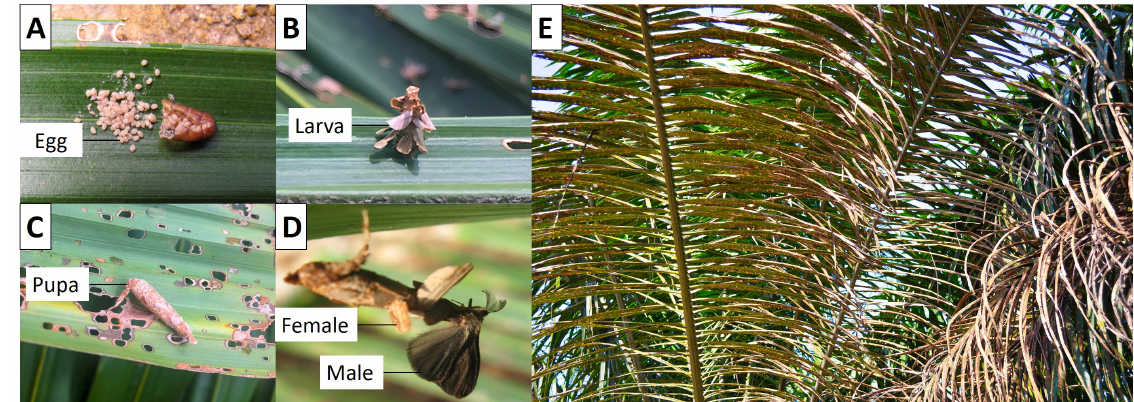
Figure 1. Developmental stages of M. plana . ( A ) Cluster of creamy-coloured eggs on the left with its casing on the right. ( B ) Third instar larva. ( C ) Pupa. ( D ) adult on the left and male adult on the right. ( E ) Leaves of oil palm tree upon bagworm outbreak on an oil palm plantation in FELDA Besout 02, Perak, Malaysia (03°46 ′ N 100°17 ′ E).